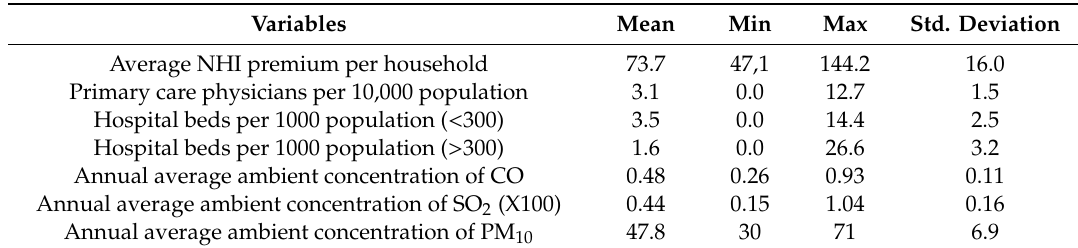
Table A1. Characteristics of independent